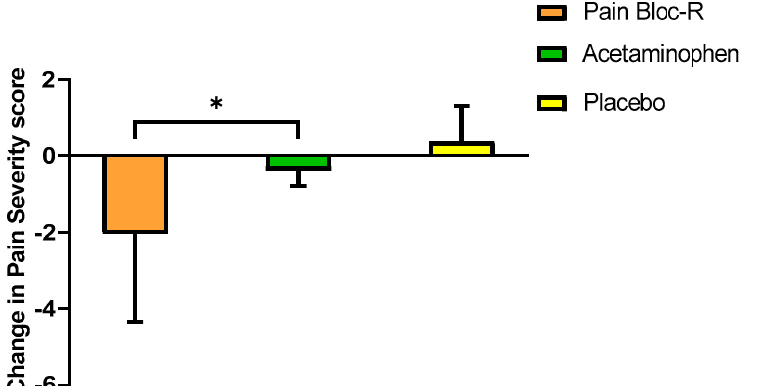
Figure 4. Change in pain severity score from pre-supplementation to post-supplementation (day 7) in the ≤ 45 years of age male PP population ( n = 6). n, number; SD, standard deviation. Between group p -values were generated using a linear mixed effect model with treatment, sequence, and period as fixed effects and subject as a random effect. Between group p -values were adjusted using Tukey’s HSD. * p ≤ 0.05 considered statistically significant.